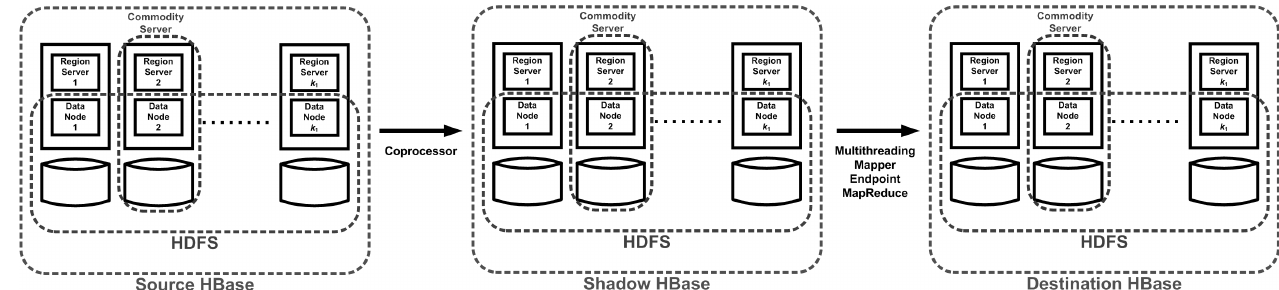
Figure 2. Overall system